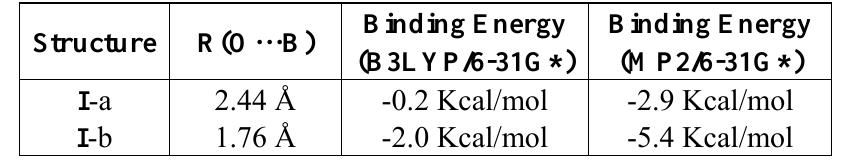
Table 2. The computed parameters for 2,3,4,6-tetra- O -acetyl  - and  - D -glucopyranose.